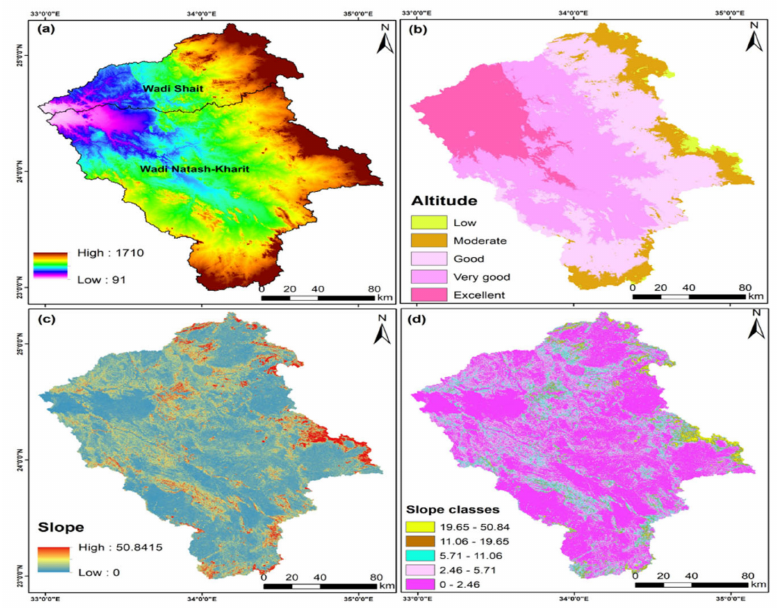
Figure 4. Topography maps: ( a ) SRTM DEM data; ( b ) topography density map; ( c ) slope map; ( d ) slope density